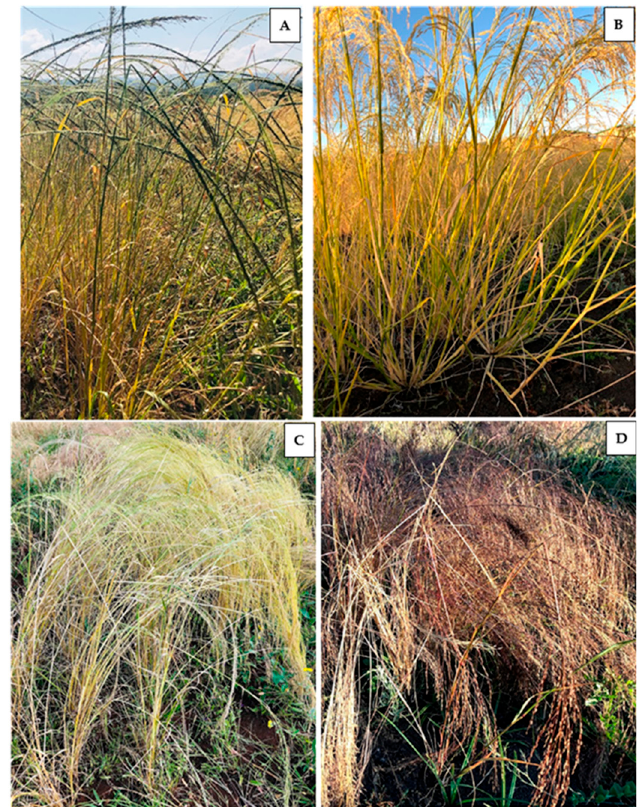
Figure 4. Lodging in selected teff accessions. ( A ) Accession 149 (55114-4). Although this accession has good standing ability at the plant base, it failed at the panicle neck. ( B ) Accession 123 (203010-4), this accession has relatively good lodging resistance but lateral tiller growth. ( C ) accession 201 (RIL-2) were susceptible to bending-type lodging. ( D ) Accession 63 (235368-1), with typical breaking-type stem lodging.